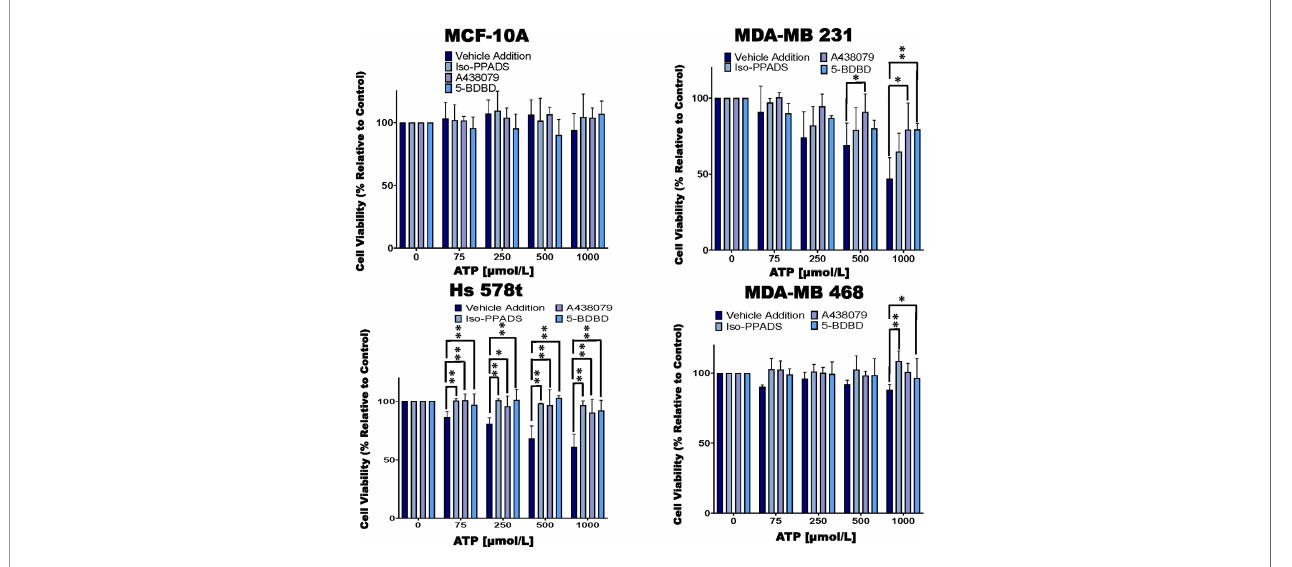
FIGURE 2 | Cell viability of ATP-treated cells in the presence of P2RX inhibitors. TNBC cell lines and MCF-10A cells were treated for 48 hours with increasing concentrations of ATP in the presence of the P2RX inhibitor Iso-PPADS (20 µmol/L), the P2RX7 inhibitor A438079 (20 µmol/L) or the P2RX4 inhibitor 5-BDBD (20 µmol/L) or vehicle addition, and cell viability was measured using the PrestoBlue HS assay. Error bars represent standard deviations calculated from three independent experiments performed in triplicate. One way ANOVA with Tukey ’ s HSD was applied to ascertain signi fi cance. * represents p < 0.05 and ** represents p < 0.01 when comparing vehicle addition to Iso-PPADS, A438079 or